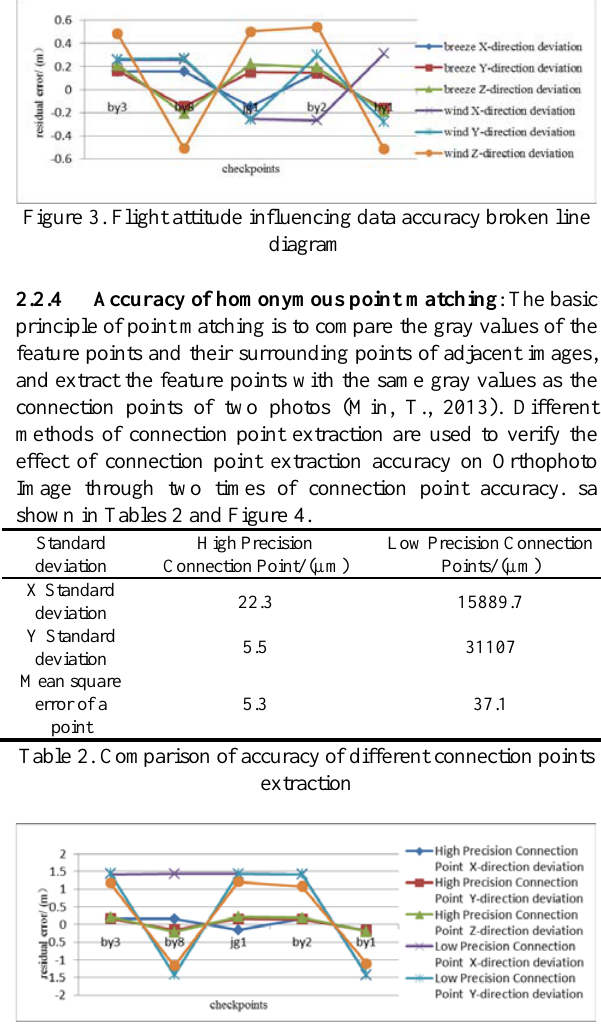
Figure 4. The matching accuracy affects the data accuracy broken line diagram